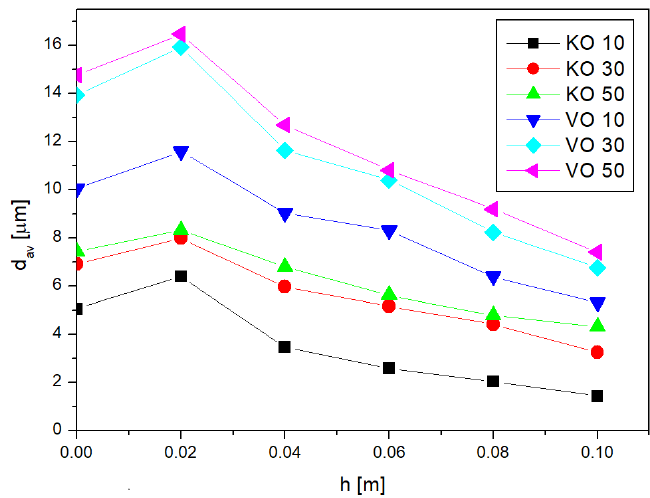
Figure 3. Dependence of the mean diameter of oil droplets on the imbibition height for different tested systems.